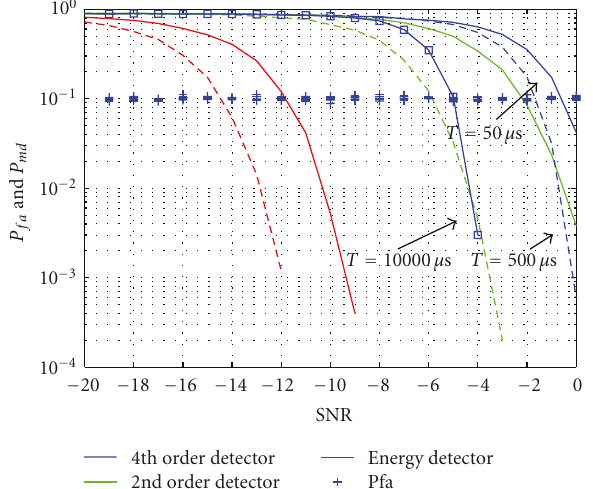
Figure 6: Energy (eng) and fourth-order detector (cf4) ROC curves for two values of the noise uncertainty (no uncertainty, 0dB uncertainty). The system parameters are: 1MHz symbol frequency, 4MHz sample frequency, square-root Nyquist pulse shaping filter of 0 . 2 roll-o ff factor, SNR = − 2